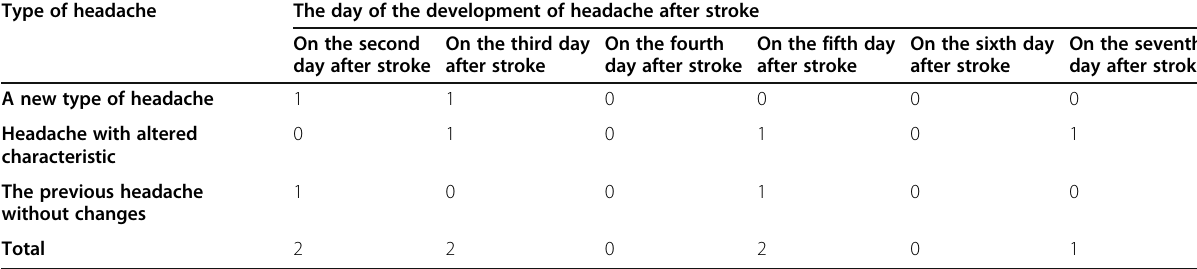
Table 5 The onset of headache during seven days after first-ever ischemic stroke *